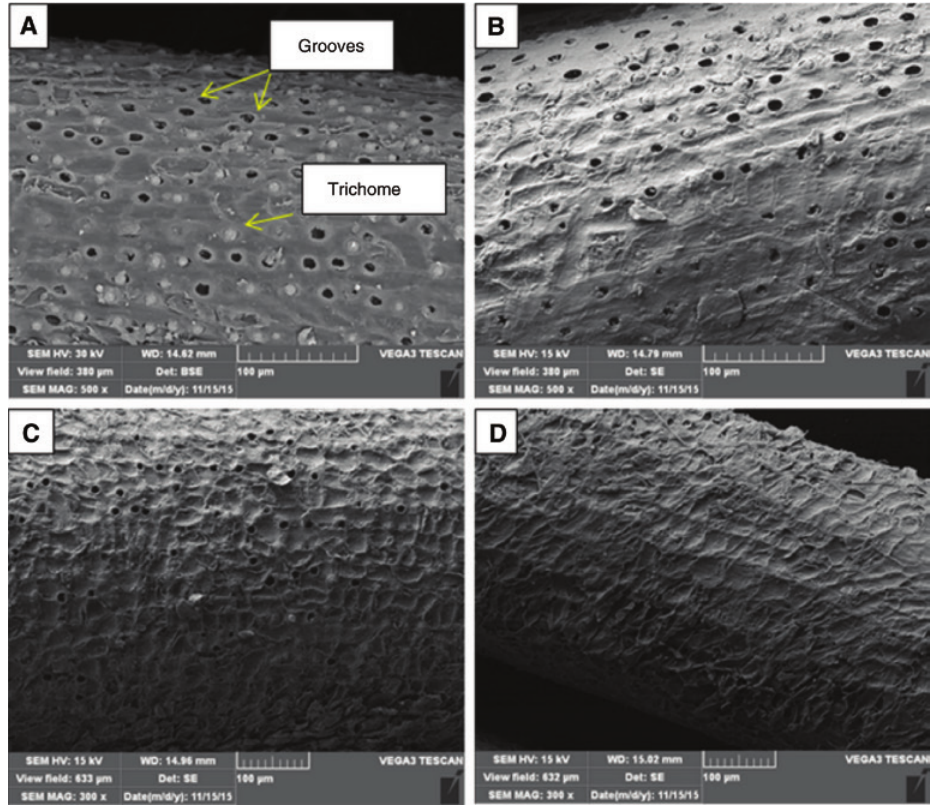
Figure 6: Micrographs of plasma-treated DPFs under different conditions: (A) A3, (B) A8, (C) B3, and (D)